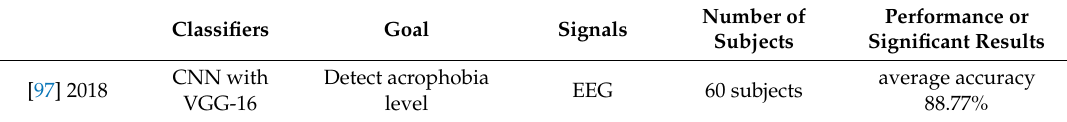
Table 1. Performance in phobia level classification using